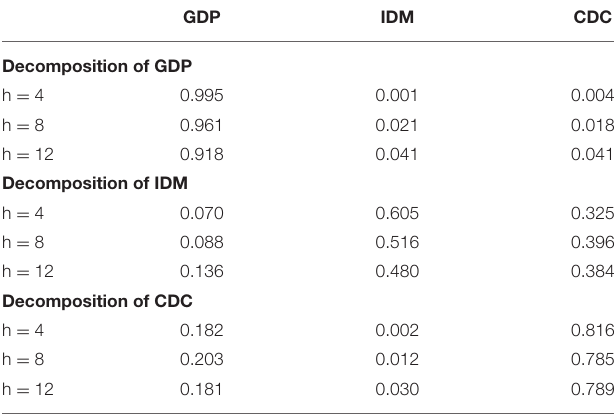
TABLE 3 | Forecast error variance decomposition of LF-VAR (4).